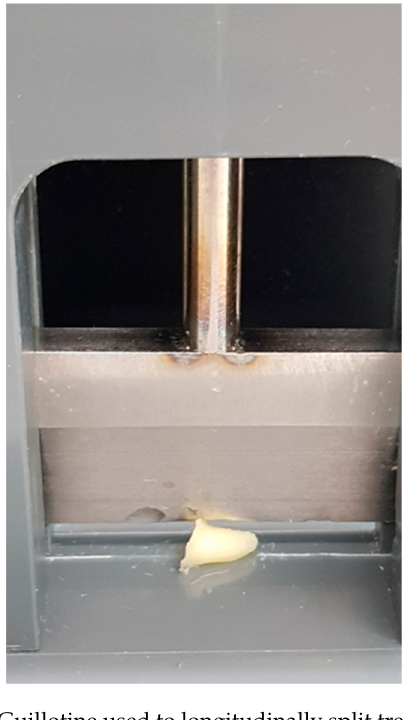
Figure 5. Guillotine used to longitudinally split treated teeth. J. Clin. Med. 2019 , 8 , x FOR PEER REVIEW